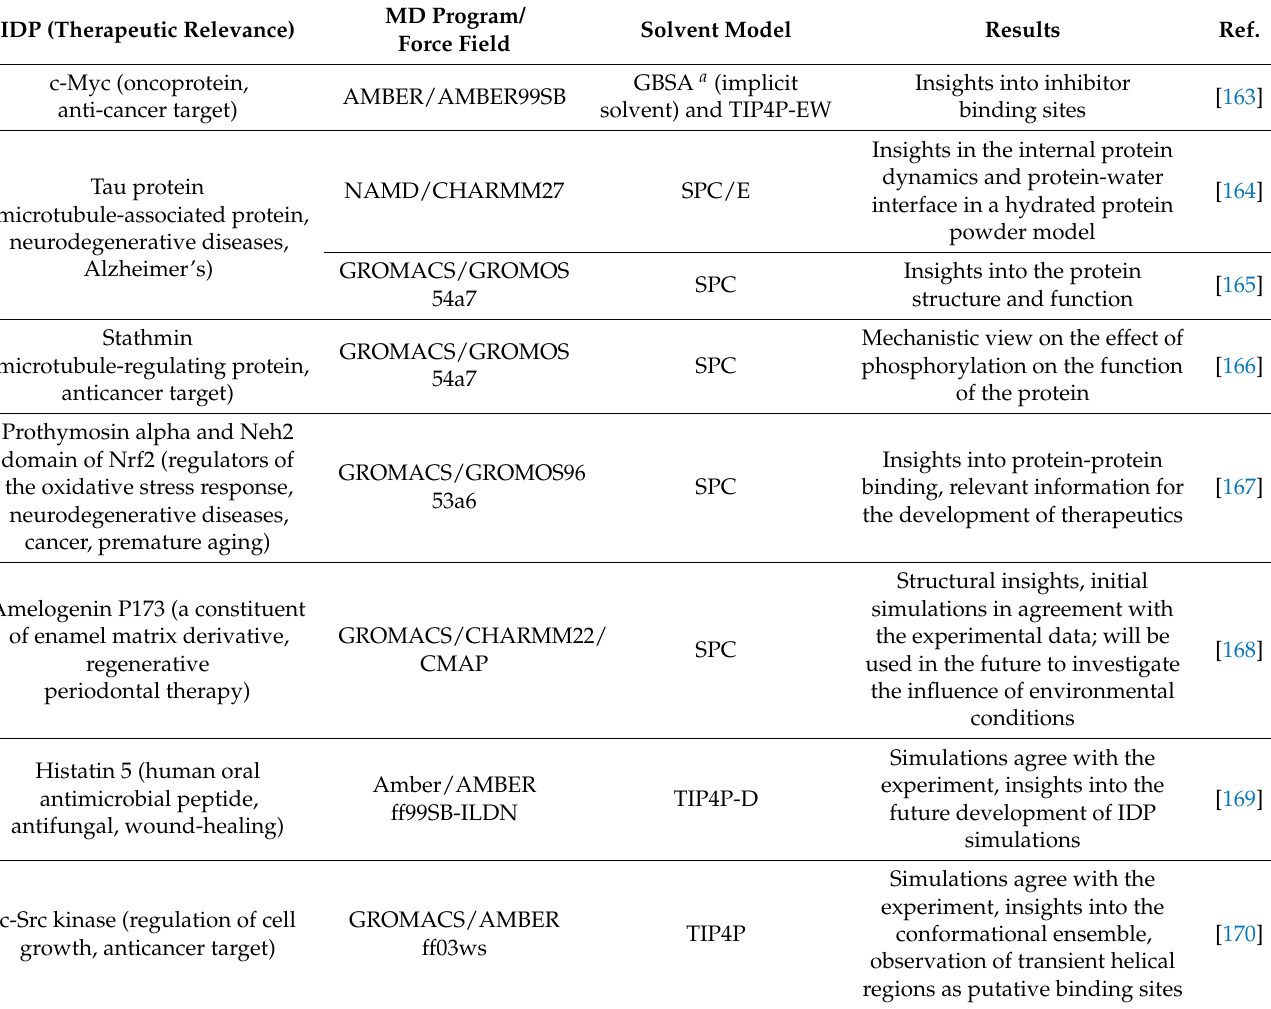
Table 2. Molecular dynamics simulation of intrinsically disordered proteins (IDPs) with various force fields and solvent models. IDP (Therapeutic